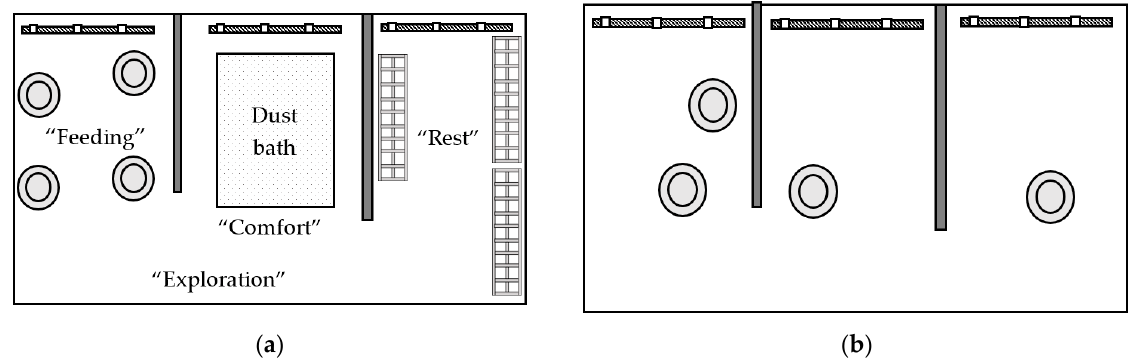
Figure 1. ( a ) High-complexity pen with four functional spaces for “feeding”, “comfort”, “resting”, and “exploration”. The feeding space contained four feeders ( ) and pecking stones, the “comfort” space included a sand dust bath ( ), the resting space contained three perches ( ), and the exploration space contained varying pairs of enrichment objects. The feeding, comfort, and resting spaces each contained a water line with three nipple drinkers ( ). ( b ) Low-complexity (control) pen, containing four feeders and three water lines.